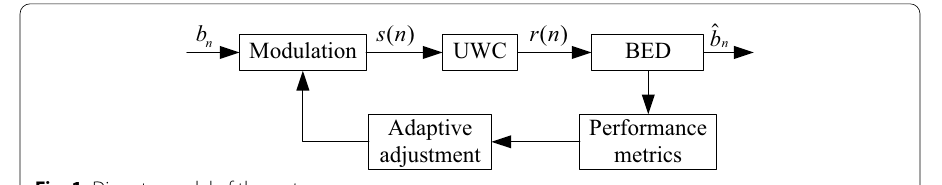
Fig. 1 Discrete model of the